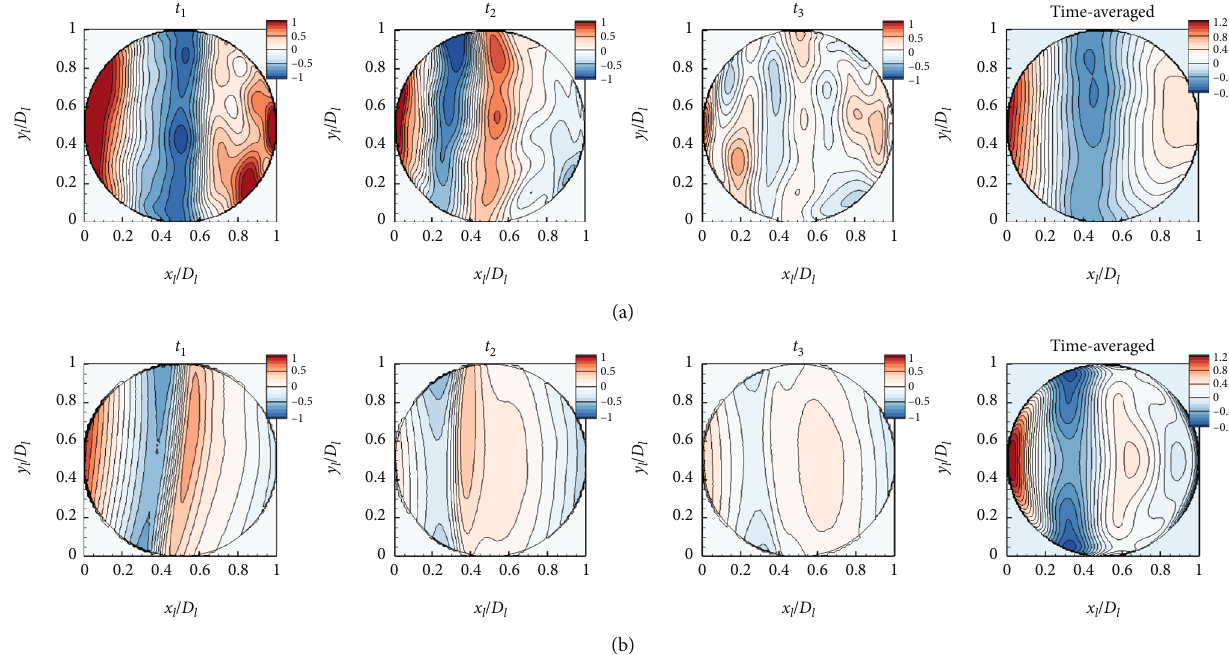
y t ÞÞ and these time averages ðh OPD ð x l , l ,